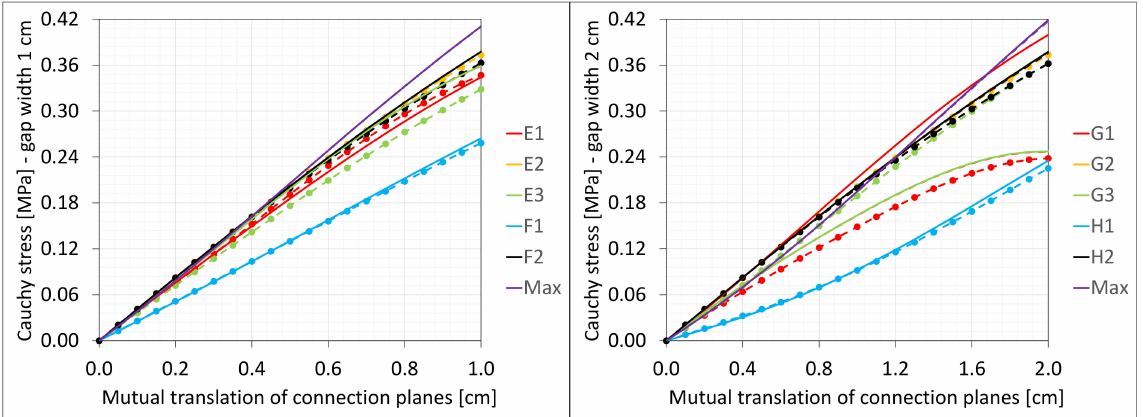
Figure 28. Equilibrium paths for stresses τ zy in selected nodes. The width of the gap is equal to 1.0 cm, left graphic, and 2.0 cm, right graphic. Plane strain models, solid lines; and 3D models, dashed lines (curves from Figure 13).